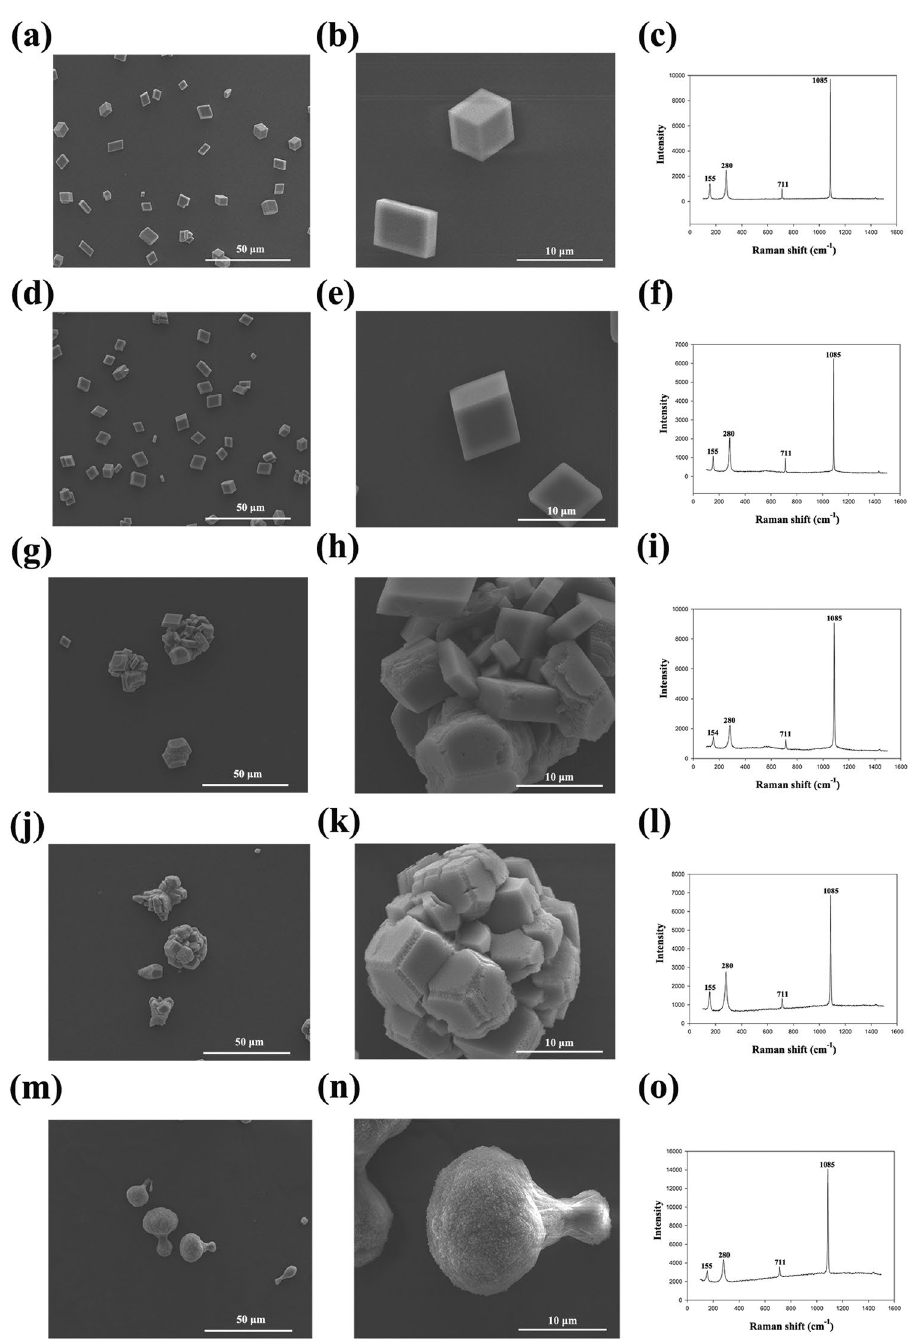
Figure 6. SEM images of in vitro calcite crystallization in the presence of rPfY2 and Raman spectrum analyses of crystals. Crystals grown in the presence of 80 μ g/ml BSA ( a , b ); 80 μ g/ml MBP ( d , e ); 30 μ g/ml rPfY2 ( g , h ); 50 μ g/ml rPfY2 ( j , k ); 80 μ g/ml rPfY2 ( m , n ). ( b , e , h , k , n ) were the amplifications of the crystals indicated by arrows in ( a , d , g , j , m ), respectively. ( c , f , i , l , o ) showed the Raman spectrum of the crystals from 80 μ g/ml BSA ( b ), 80 μ g/ml MBP ( e ), 30 μ g/ml rPfY2 ( h ), 50 μ g/ml rPfY2 ( k ) and 80 μ g/ml rPfY2 ( n ),